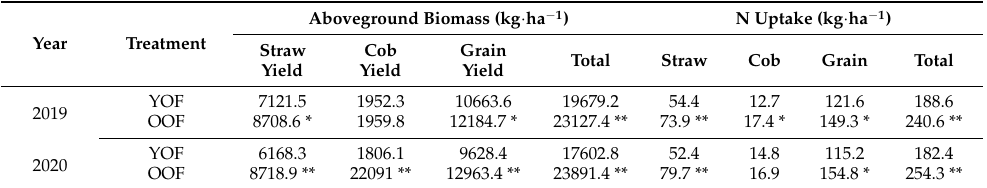
Table 5. Aboveground biomass and plant N uptake in the YOF and OOF.